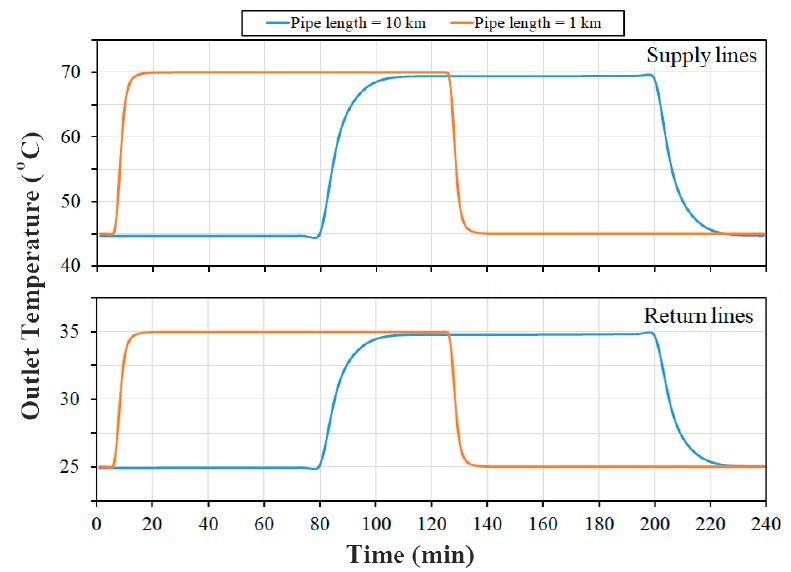
Figure 16. The trend of outlet temperature in a VTDH system with different pipe lengths.